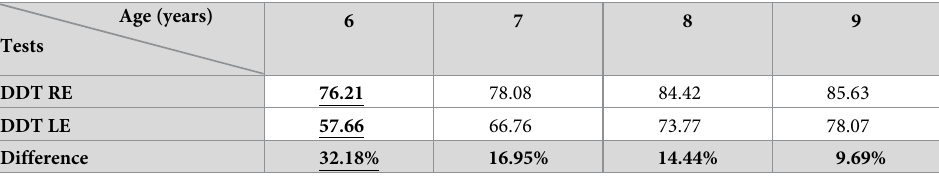
Table 14. Comparison of mean results for DDT RE and LE (dependent samples) and the difference between the results for group”C”.